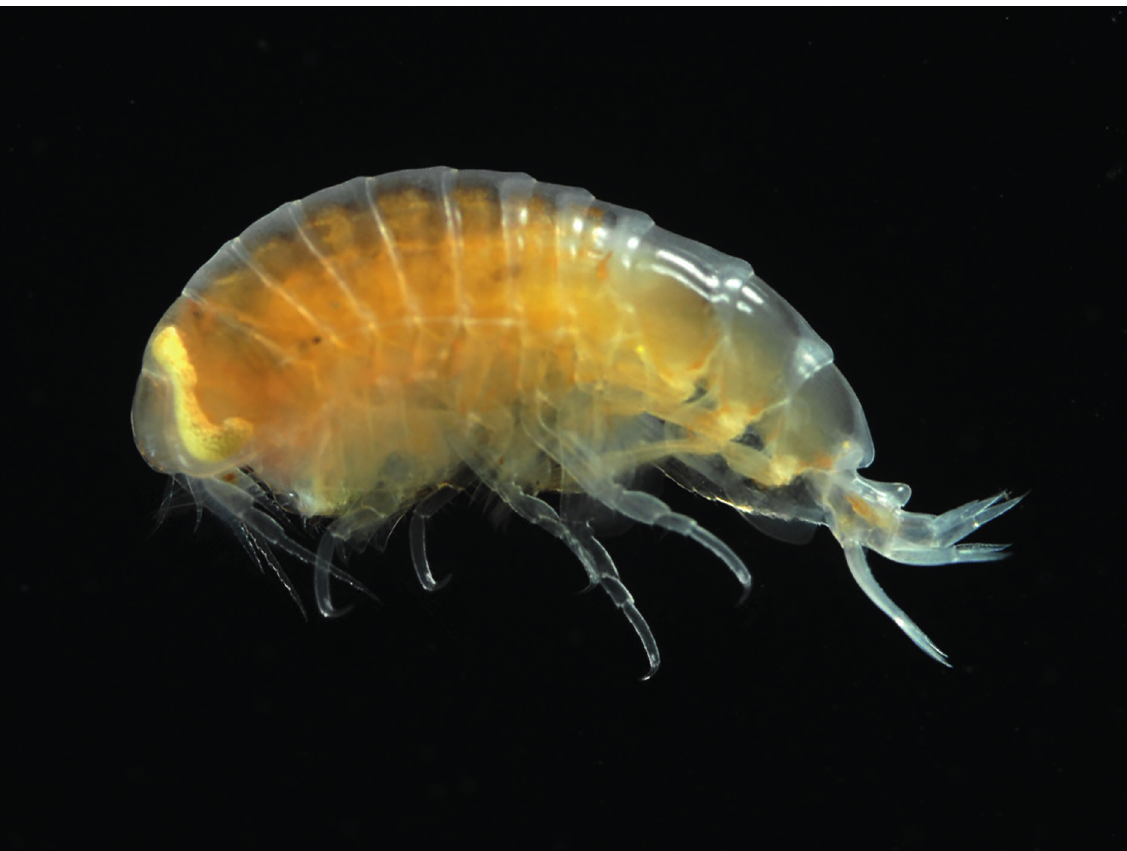
Fig. 10. Abyssorchomene patriciae sp. nov., habitus, ♂, size unknown, RRS James Cook (2007), Northwest Atlantic, Mid-Atlantic Ridge, north of Charlie-Gibbs Fracture Zone, station JC 011-079, 53°56.44′ N, 36°11.56′ W, depth 2564 m, trap deployed 5 August 2007 (photo taken August 7, 2007 by David Shale, permission